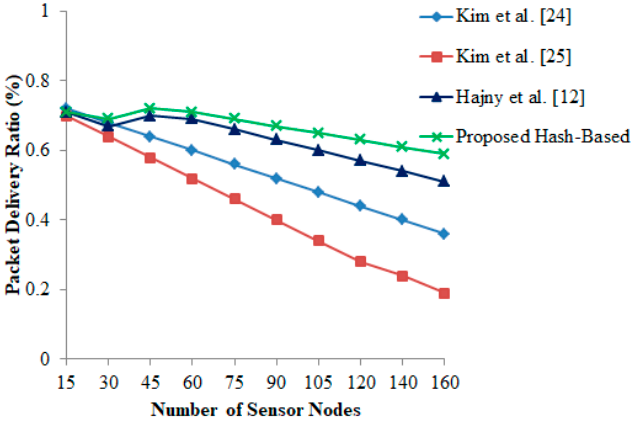
Figure 4. Packet delivery ratio vs. number of sensor nodes.